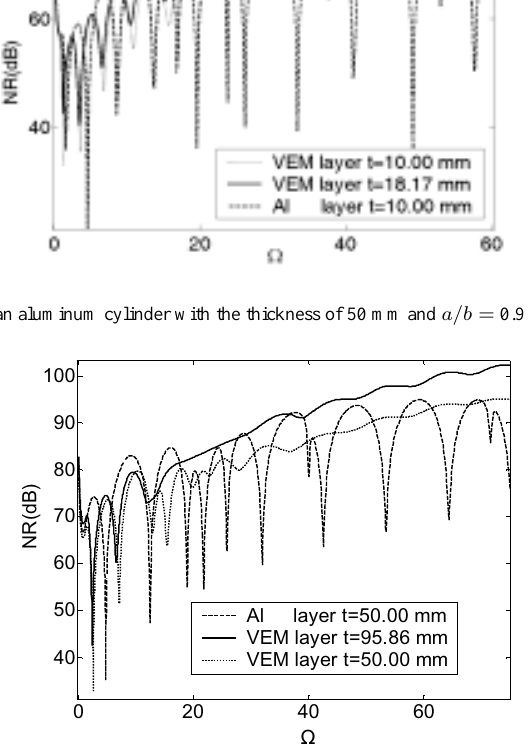
Fig. 9. Noise reduction for an aluminum cylinder with the thickness of 100 mm and a/b = 0.8 with various internal